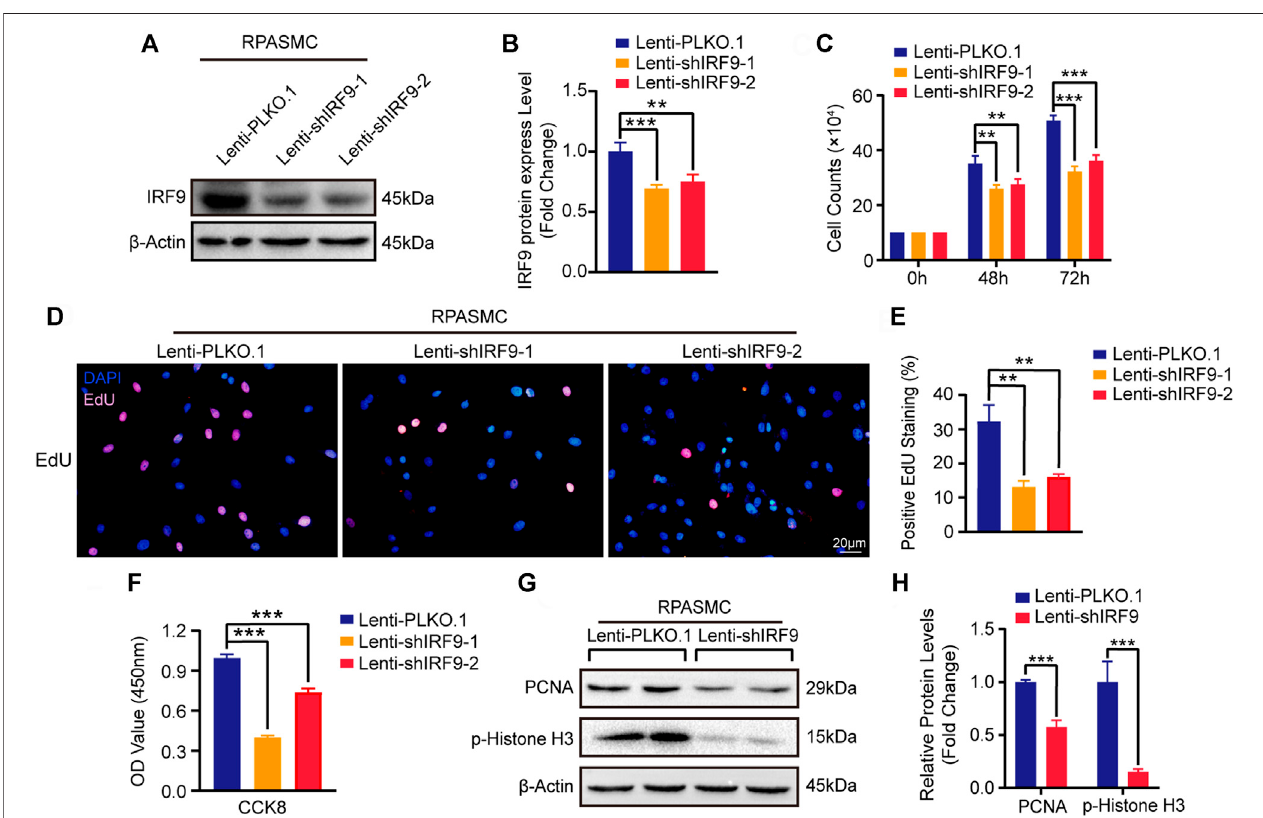
FIGURE 3 | IRF9 knockdown decreases the proliferation of RPASMCs. (A) The expression level of IRF9 was veri fi ed by western blot after knockdown IRF9 by infected indicated lentiviruses (Lenti-shIRF9-1, Lenti-shIRF9-2) or not (Lenti-PLKO.1) in RPASMCs under normoxia condition. (B) The protein level of IRF9 were normalized to β -Actin and quanti fi ed ( n (cid:2) 3 independent experiments). (C) Cell counting assay shows the count of RPASMCs with Lenti-PLKO.1 or Lenti-shIRF9-1/2 at time point culturing for 0, 48 and 72 h under normoxia condition ( n (cid:2) 3 independent experiments). (D) EdU incorporation assay shows the ratio of RPASMCs incorporatedwithEdUafterinfectedwithLenti-shIRF9-1/2orLenti-PLKO.1undernormoxiacondition,inwhichnucleiarestainedwithDAPI(blue)andincorporatedEdU mergedwithDAPIareshowninpink.Scalebar,20 μ m. (E) ThepositiveEdUstainingratesweremeasured( n (cid:2) 3independentexperiments). (F) CCK-8assayshowsthe decrease of absorbance at 450 nm which indicate the attenuation of proliferation capacity in Lenti-shIRF9-1/2 RPASMCs comparing to Lenti-PLKO.1 under normoxia condition( n (cid:2) 3independentexperiments). (G) TheproteinlevelsofproliferationbiomarkersPCNAandp-HistoneH3weredeterminedinIRF9-knockdownRPASMCsin normoxia condition. (H) The expression levels of PCNA and p-Histone H3 were normalized to β -Actin and quanti fi ed ( n (cid:2) 3 independent experiments). Values are means ± SD; *** p < 0.001, ** p < 0.01.